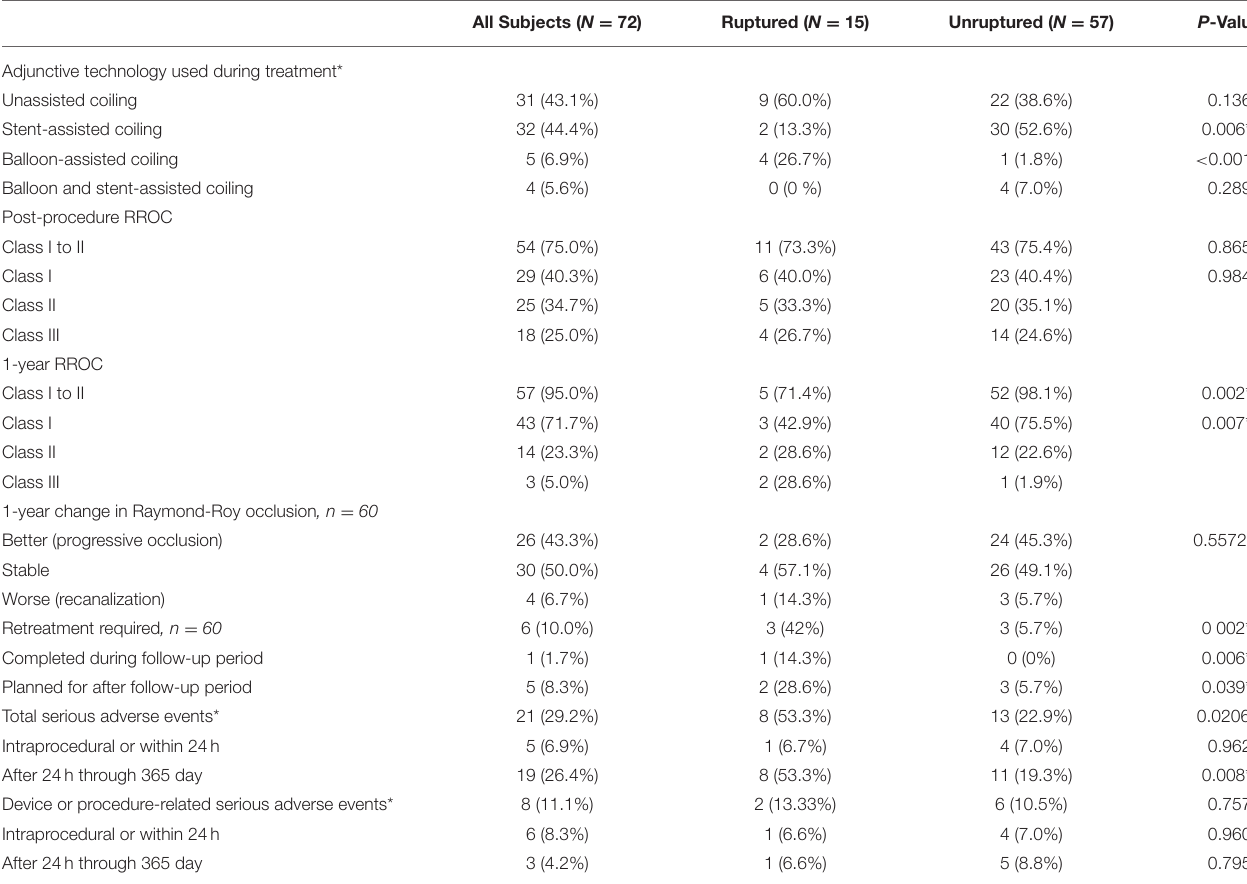
TABLE 3 | Safety and efficacy outcomes. All Subjects ( N = 72) Ruptured ( N = 15) Unruptured ( N = 57) P